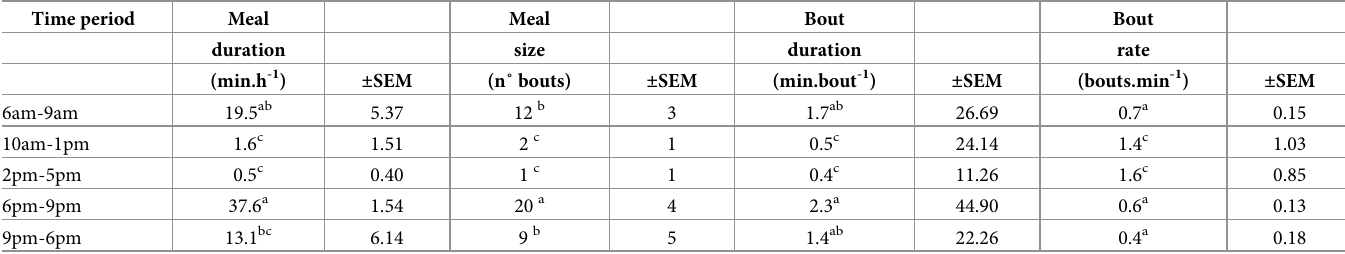
Table 3. Daily variation in structure of intake (meal and bout pattern). Time period